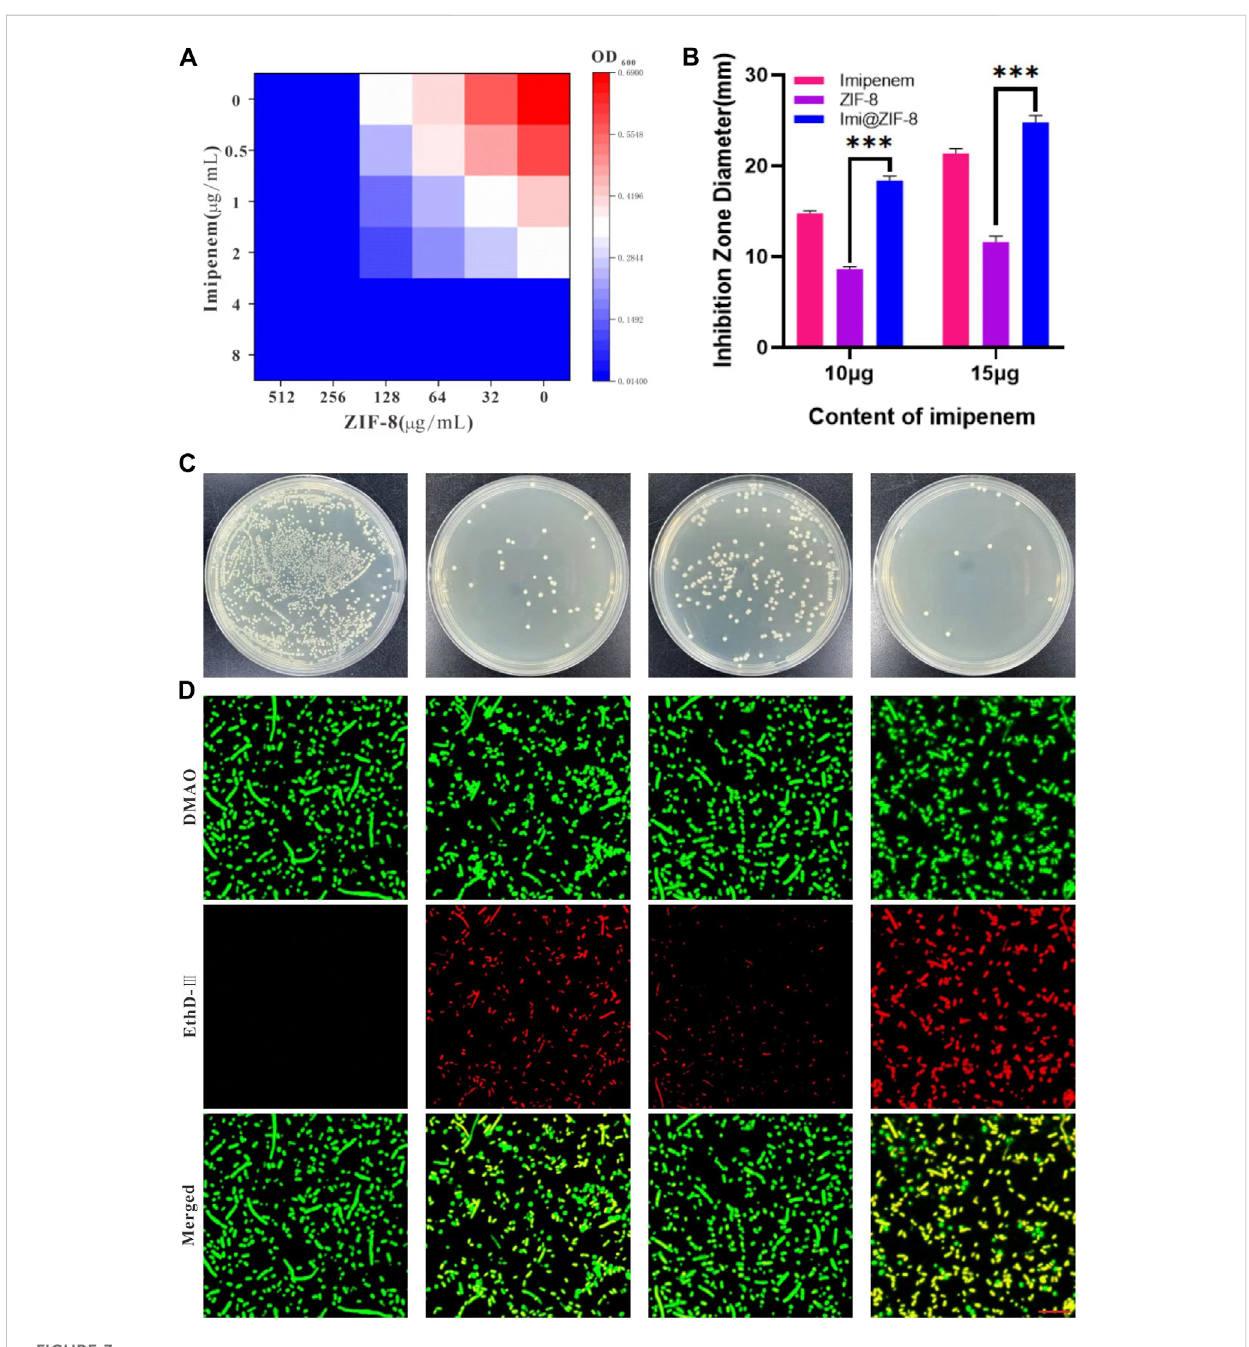
FIGURE 3 In vitro antibacterial effect of Imi@ZIF-8. (A) Different concentration of Imipenem and ZIF-8 inhibited on the growth of A. baumannii . (B) Corresponding inhibition zone diameters of imipenem, ZIF-8 and Imi@ZIF-8 against A. baumannii . (C) Photographs of agar plates showing the antibacterialactivityforPBS,imipenem,ZIF-8andImi@ZIF-8against A.baumannii . (D) CLSMimagingofdeath/livestainingafter A.baumannii exposureto various treatments(PBS,imipenem,ZIF-8and Imi@ZIF-8) for24 h.Scalebaris20 μ m.Dataarepresentedasmean±SD( n =3).ComparedtoZIF-8: *** p <